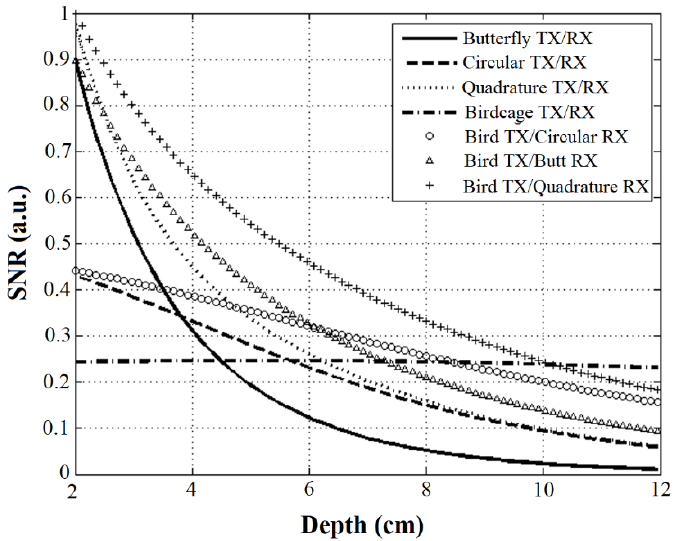
Figure 10. Theoretical SNR profiles obtained for 13 C coils with different geometries and in different configurations. Reprinted by permission from Giovannetti et al., Measurement 2015 [67].